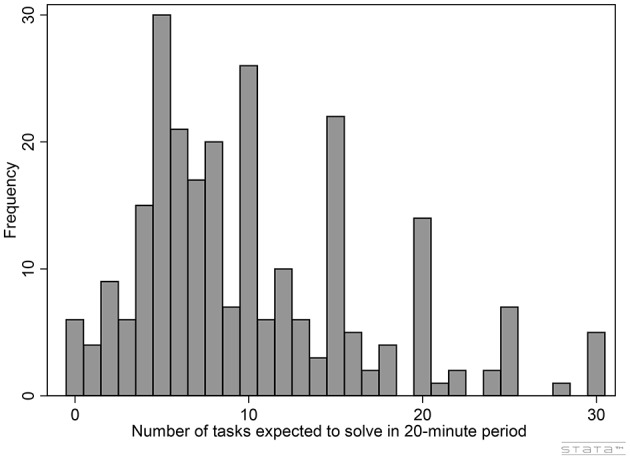
Self-confidence measure: frequency.